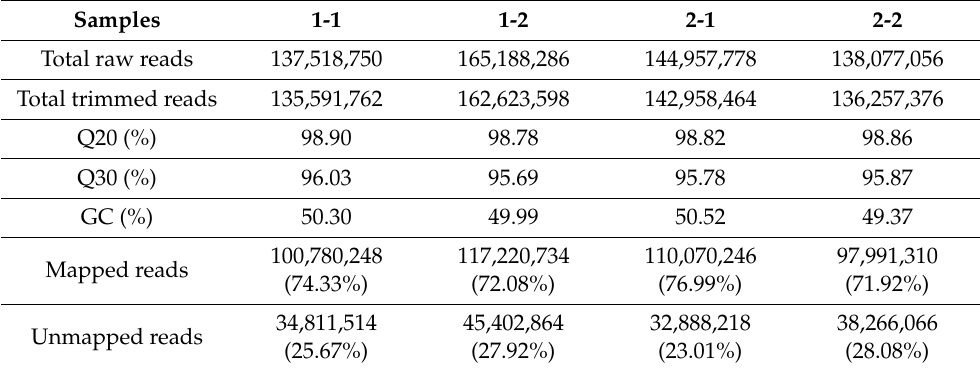
Table 1. Summary of the A. pusilla leaf transcriptome.